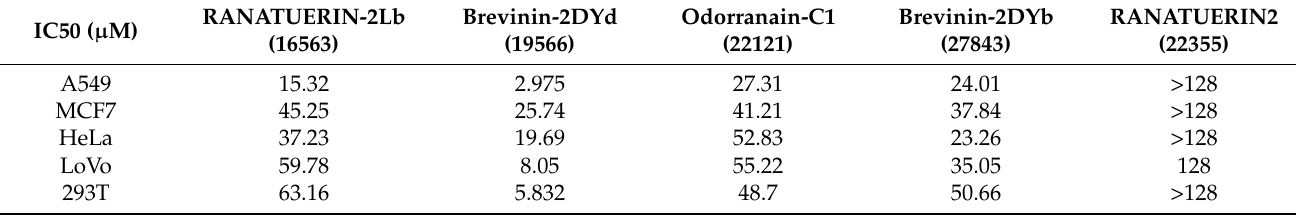
Table 6. The IC50 values of 5 peptides inhibited the proliferation of 5 kinds of cells in